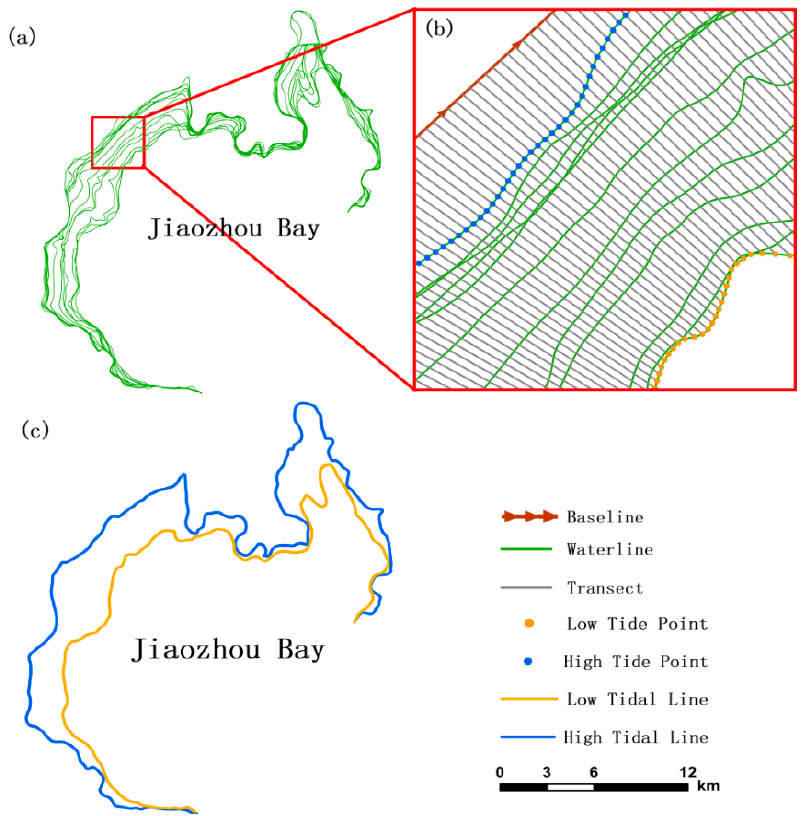
Figure 8. High and low tide line extraction process by the waterline method. ( a ) Waterline extraction results; ( b ) high and low tide point extraction results; ( c ) high and low tide line extraction results. Fifteen Sentinel-2 images in the study area in 2020 were selected for the tidal flat waterline extraction experiments. First, the EWBI values were calculated to extract the waterlines of 15 images through methods such as threshold segmentation, edge detection, and visual interpretation, and the results are shown in Figure 8a. Second, the DSAS tool was used to generate a cross-section every 100 m for a total of 990 cross-sections. Each section generated 15 tide points along the waterline, for a total of 14,850 tide points. The distance between each tide point and the baseline was calculated in each section, and the farthest point from the baseline and the nearest point were filtered out, constituting the high tide point set and low tide point set, as shown in Figure 8b. Finally, all the high tide points and low tide points were connected to generate the annual high tide line and low tide line, as shown in Figure 8c. In this way, the area between the final high and low tide lines in Figure 8c was the tidal flat area of Jiaozhou Bay in 2020 obtained by the waterline